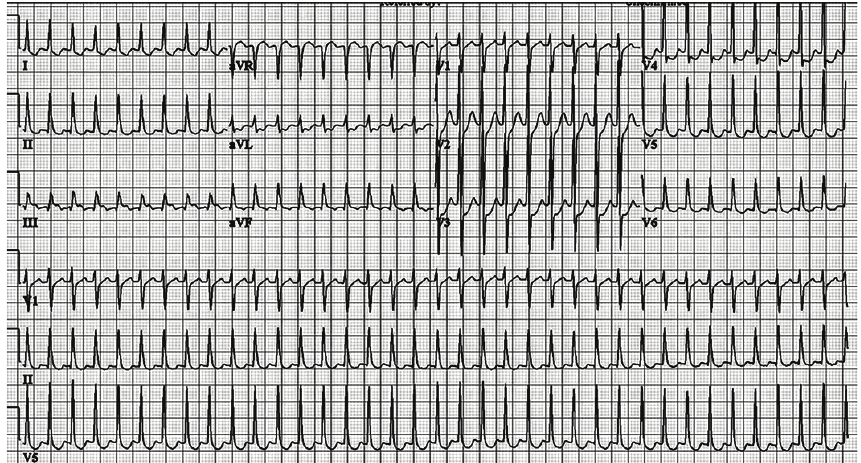
Figure 1: 12-lead ECG on admission exhibiting supraventricular tachycardia with short RP interval.